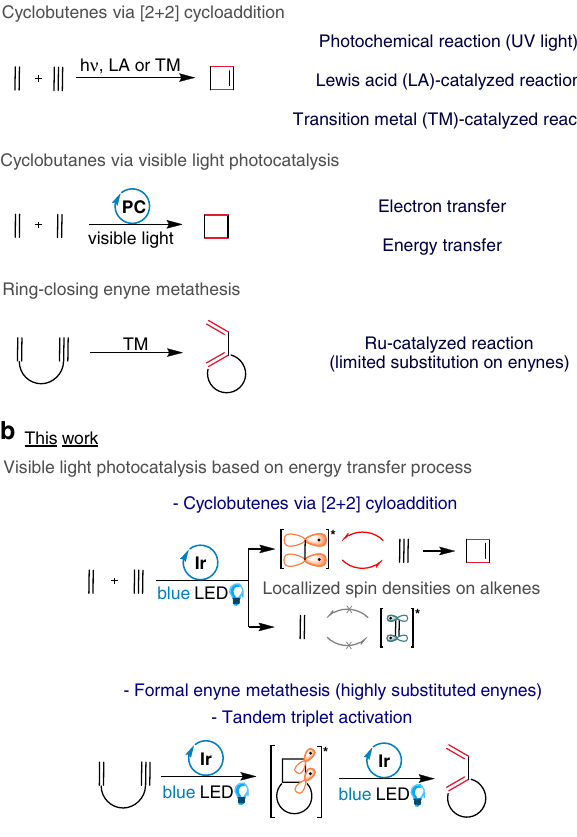
Fig. 1 Synthesis of 4-membered ring carbocycles. a Previous works for the synthesis of cyclobutenes, cyclobutanes, and 1,3-dienes. b This work for the synthesis of cyclobutenes and 1,3-dienes via visible light EnT